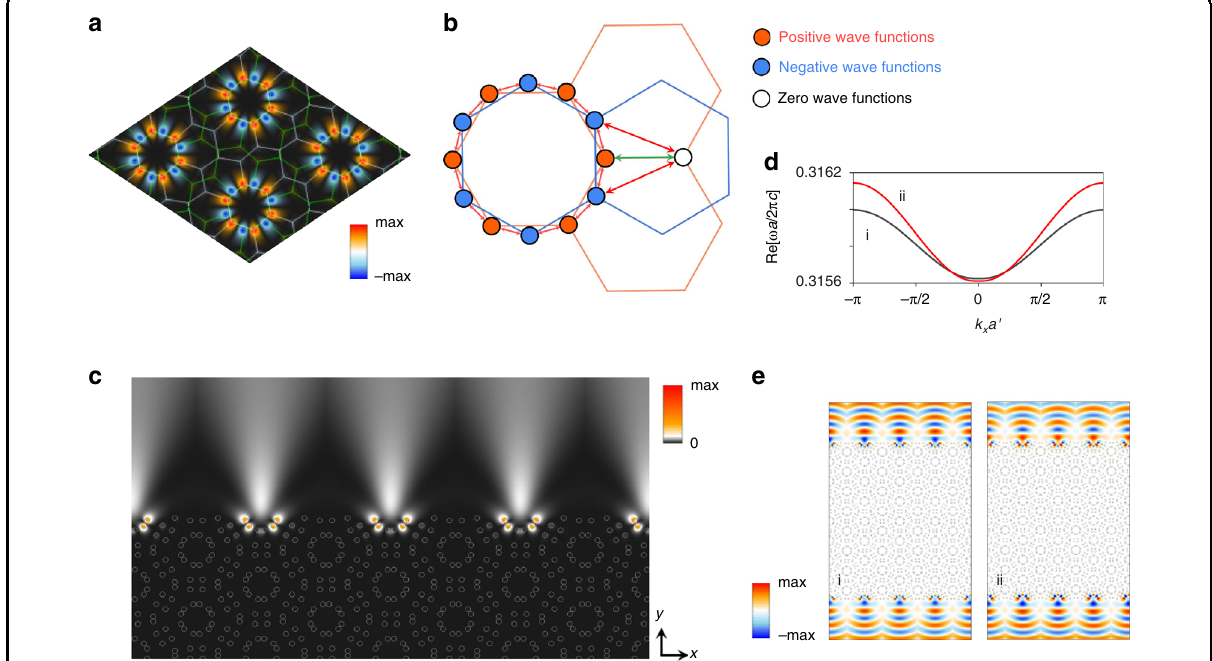
Fig. 3 Moiré pattern-induced destructive interference and atomic orbitals. a Wave function of the fl at bands. We fi nd that the wave functions form localized standing waves around the innermost dodecagonal quasi-atoms near the rotational center with sign oscillations. b Illustration of the destructive interference effect in the wave functions of the fl at bands. The alternating signs of the standing waves introduce destructive interference in the hopping to outer quasi-atoms. c Intensity ( ψ j j 2 ) pattern of the edge modes magni fi ed along the upper edge of the lattice. d , e Energy dispersion of two edge modes and corresponding wave functions of Re( ψ ) obtained for k x ¼ 0. Wave functions i and ii represent the symmetric and antisymmetric modes,